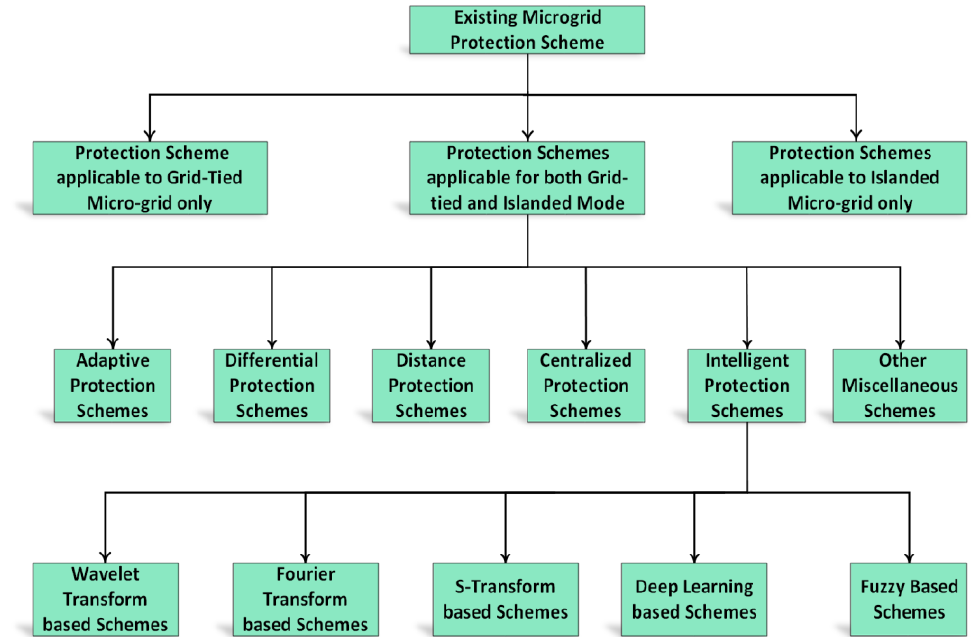
Figure 1. A schematic classification of the MG protection scheme.